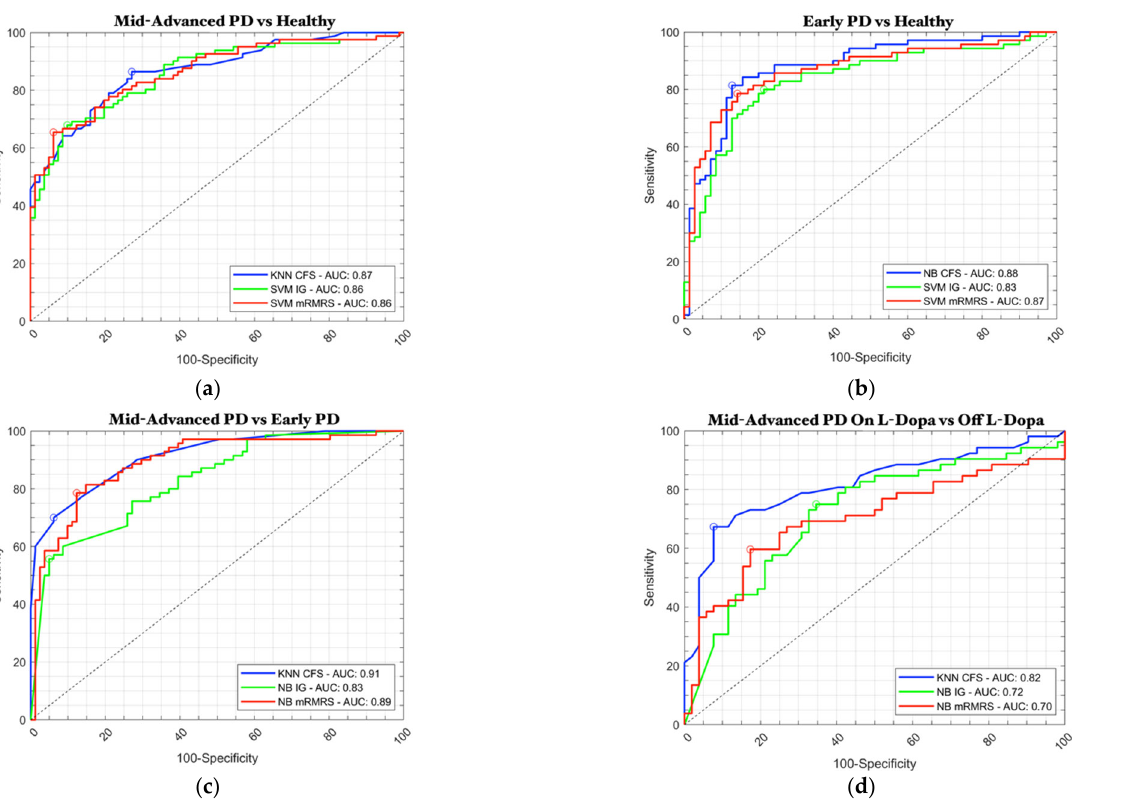
Figure 5. ROC curve comparison: ( a ) mid-advanced-stage PD patients vs. healthy control group; ( b ) early-stage PD patients vs. healthy control group; ( c ) mid-advanced-stage vs. early-stage PD patients; ( d ) mid-advanced-stage PD patients ON L-Dopa therapy vs. OFF L-Dopa therapy.